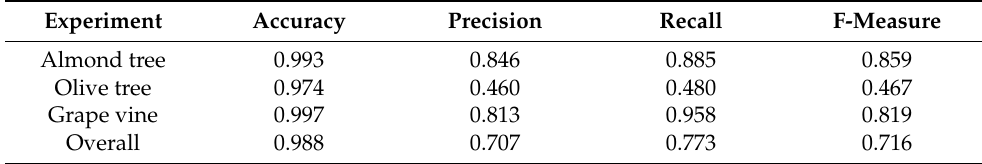
Table 6. Accuracy, precision, recall and